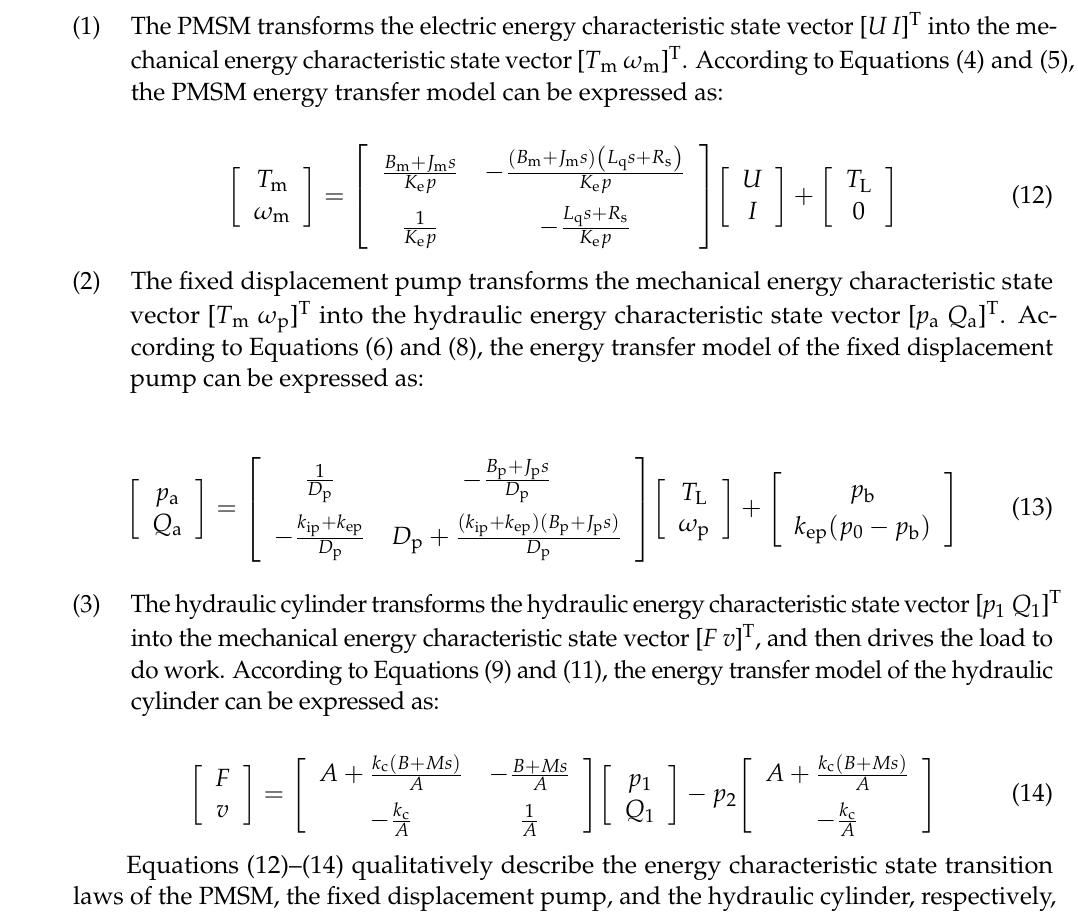
Figure 3. EHSPCS energy transfer state diagram.